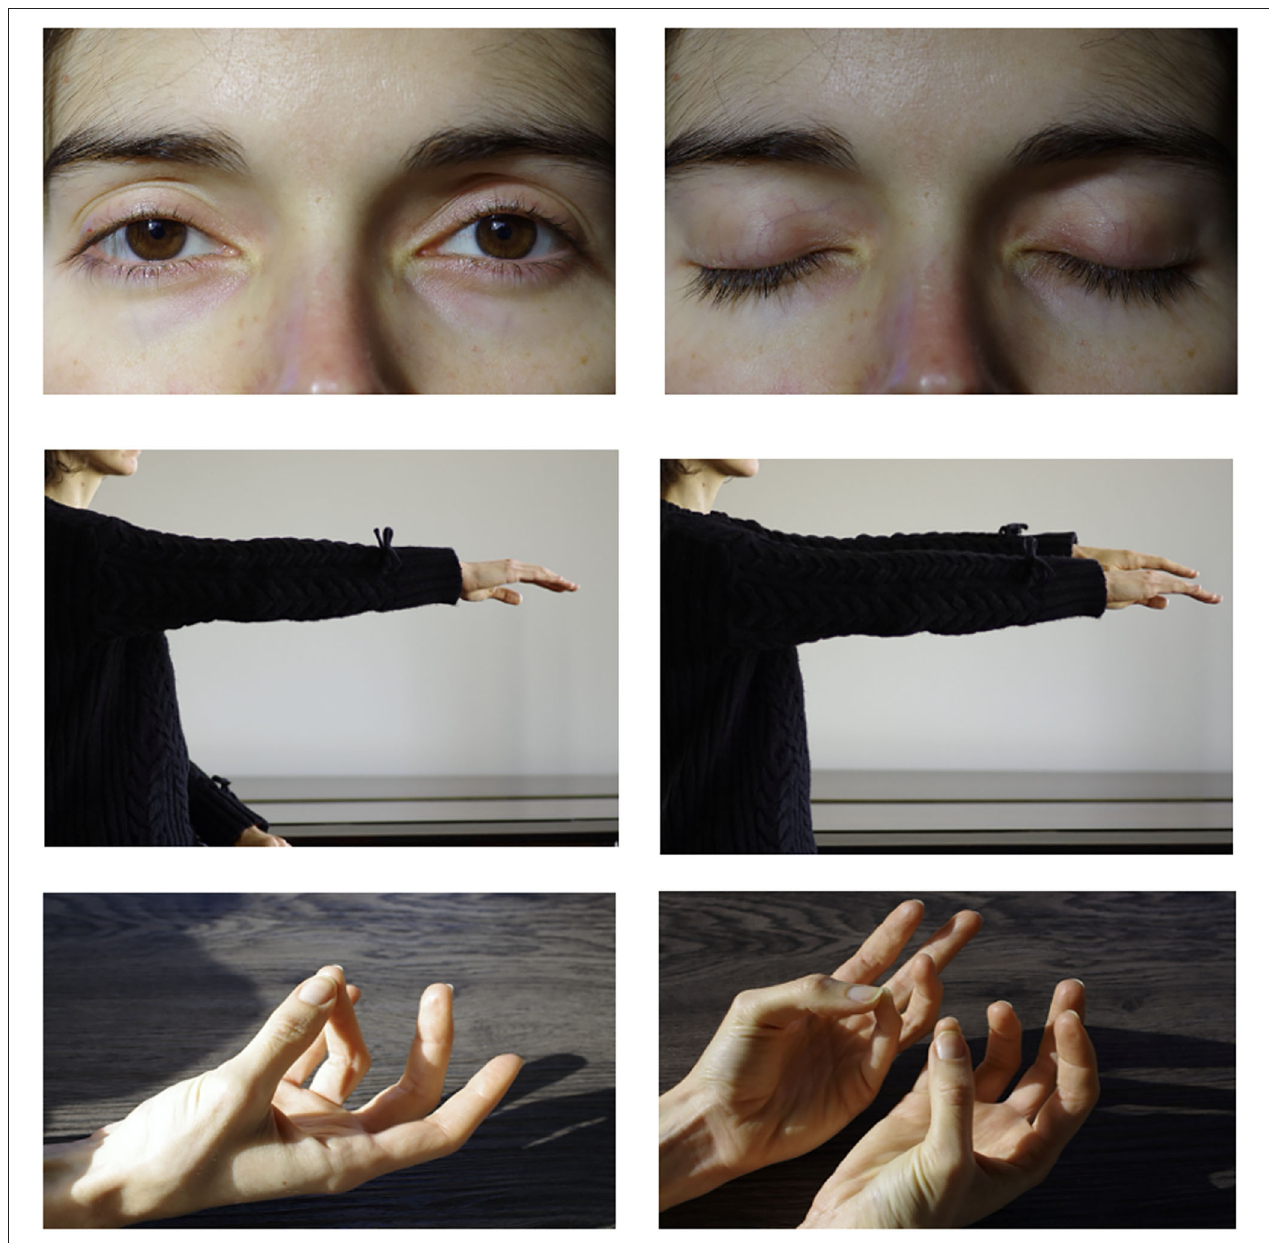
FIGURE 2 | EEG tasks: eyes opening + closure (top) , arm elevation (middle) , thumb opposition (bottom) .